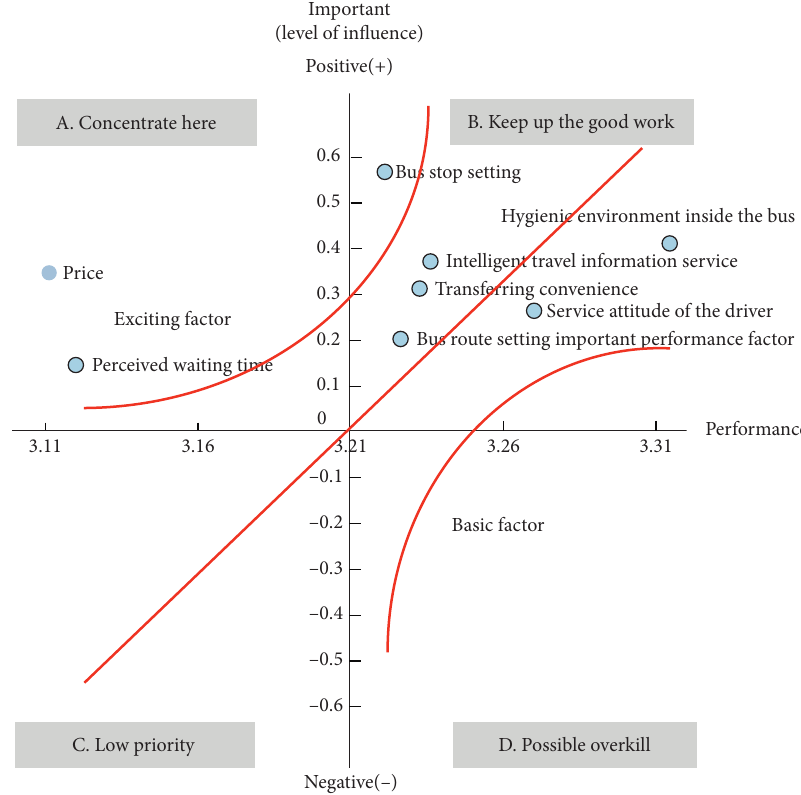
Figure 4: IPA matrices of passengers’ satisfaction toward bus